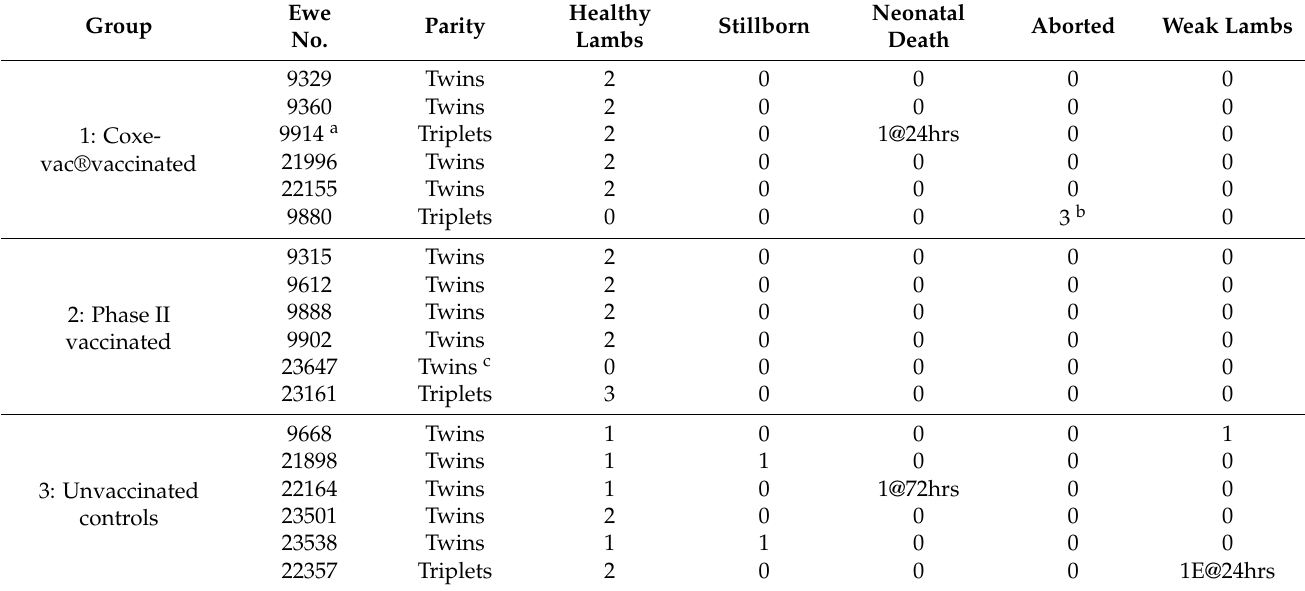
Table 5. Lambing outcome